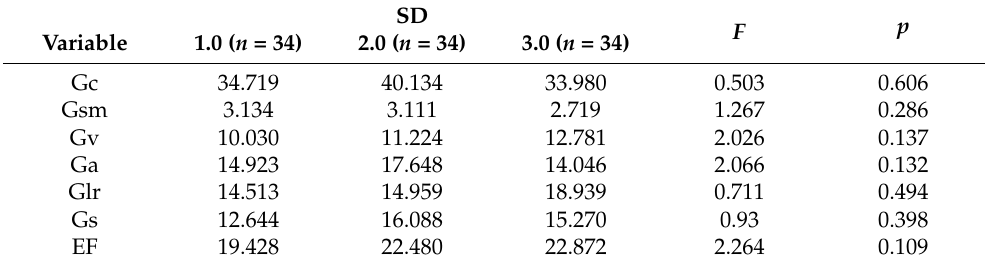
Table 4. One-way ANOVA tests on each of the seven CHC factors according to the study groups.